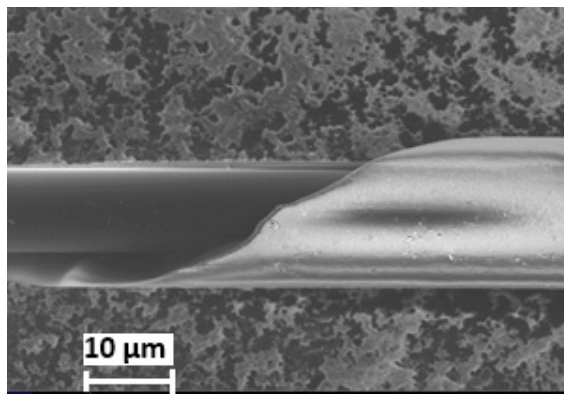
Figure 4. SEM image of the microwire with the composition of Fe 77.5 B 15 Si 7.5 .